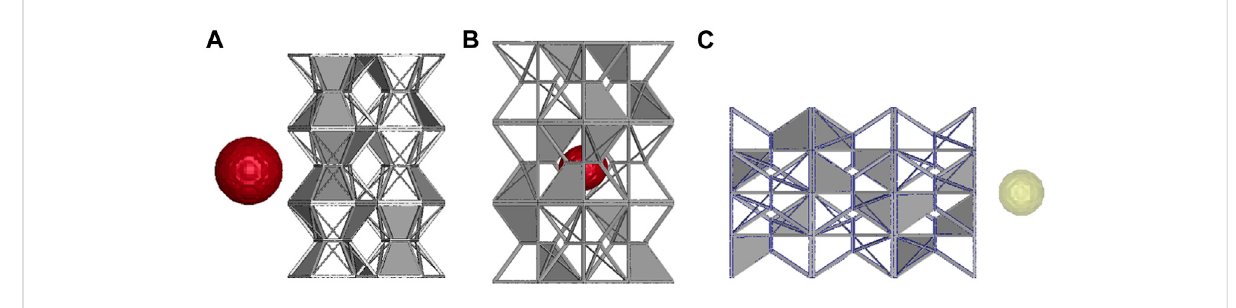
FIGURE 4 Explosion modelofdifferentexplosionlocations oftheUAV fueltankstructure. (A) Explosionlocationpoint 1. (B) Explosionlocationpoint2. (C) Explosion location point 3.